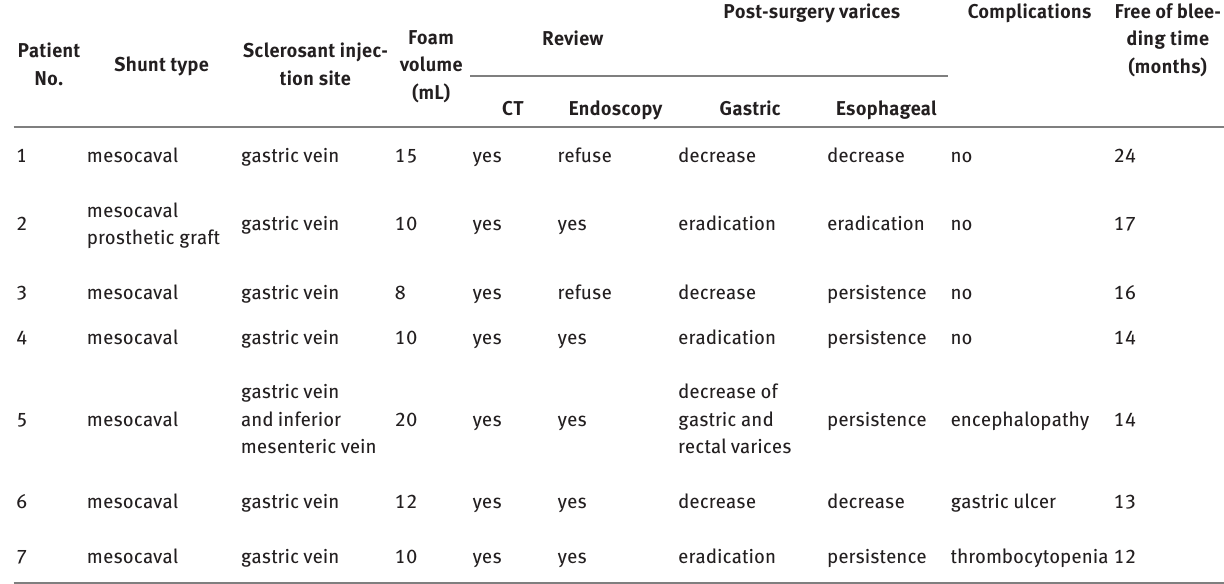
Table 2 : Postoperative results